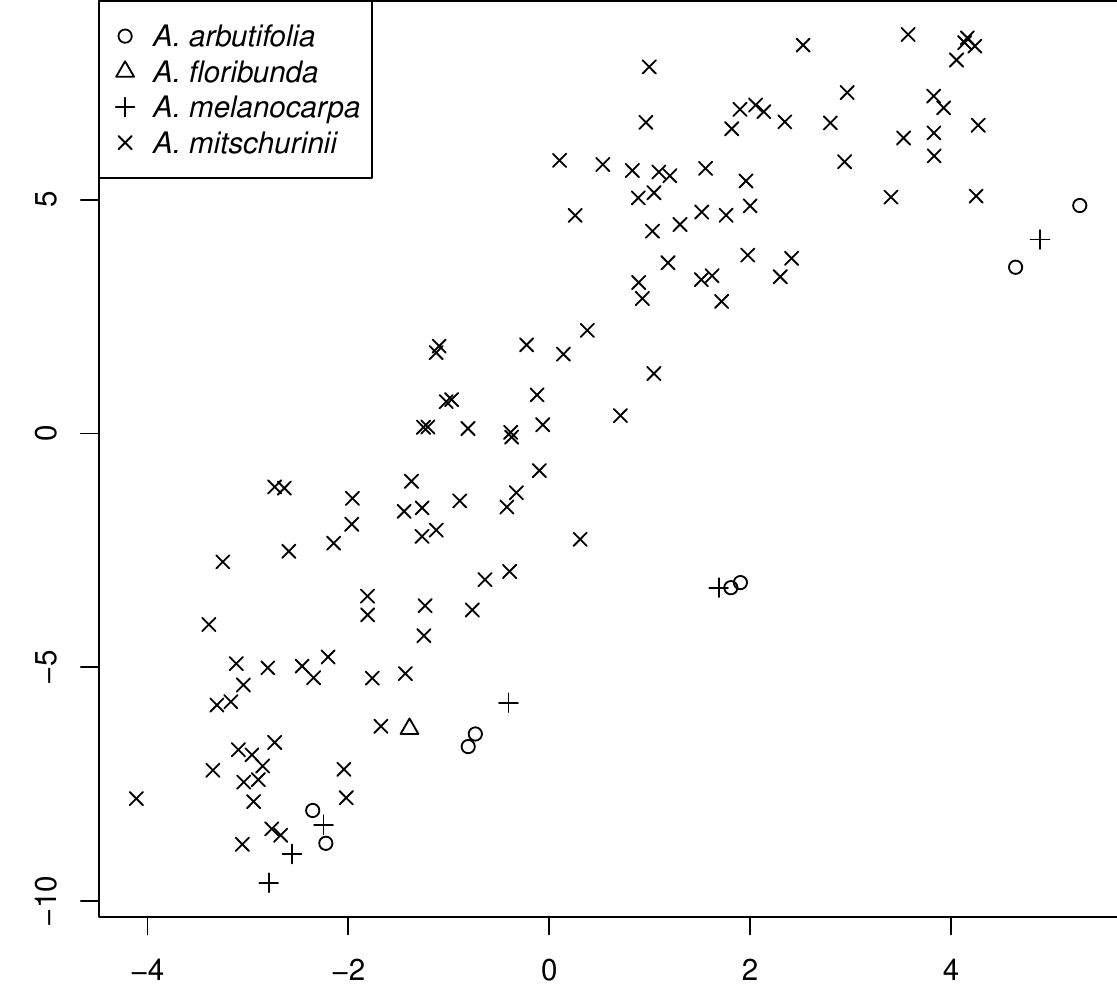
Fig. 9. t-SNE ordination of the combined morphology + geometric morphometrics